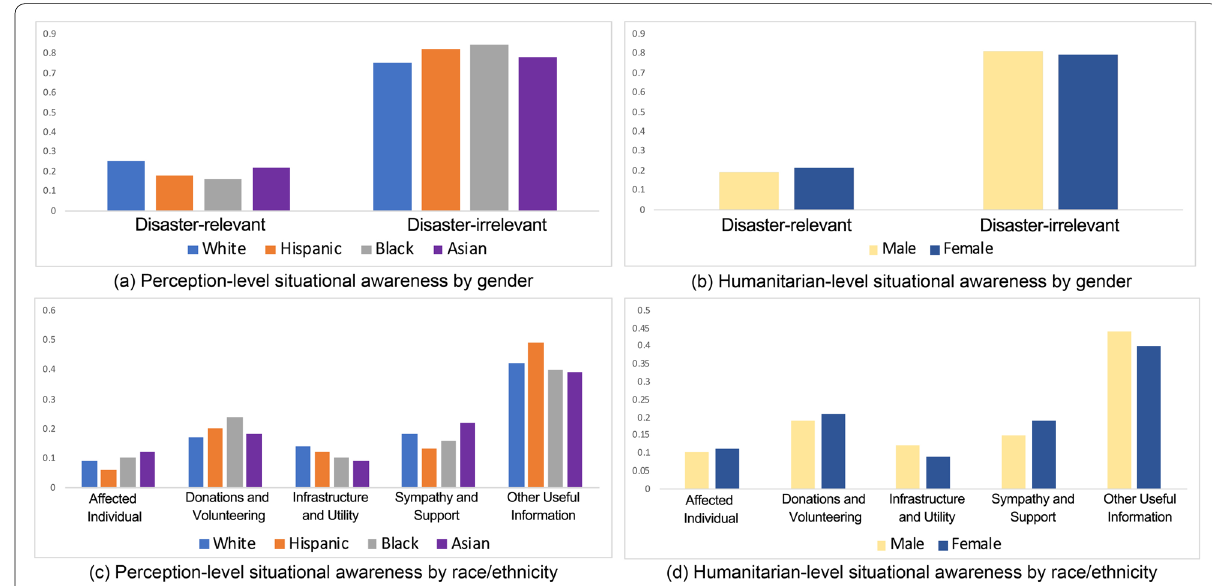
Table 6 Action-level situational awareness by gender and race/ethnicity (top 10) White Hispanic Black Asian Female Male (storm, come) (safe, stay) (hurricane, hit) (money, donate) (traffic, congest) (power, lost) (house, clean) (hurricane, pray) (rain, come) (landfall,